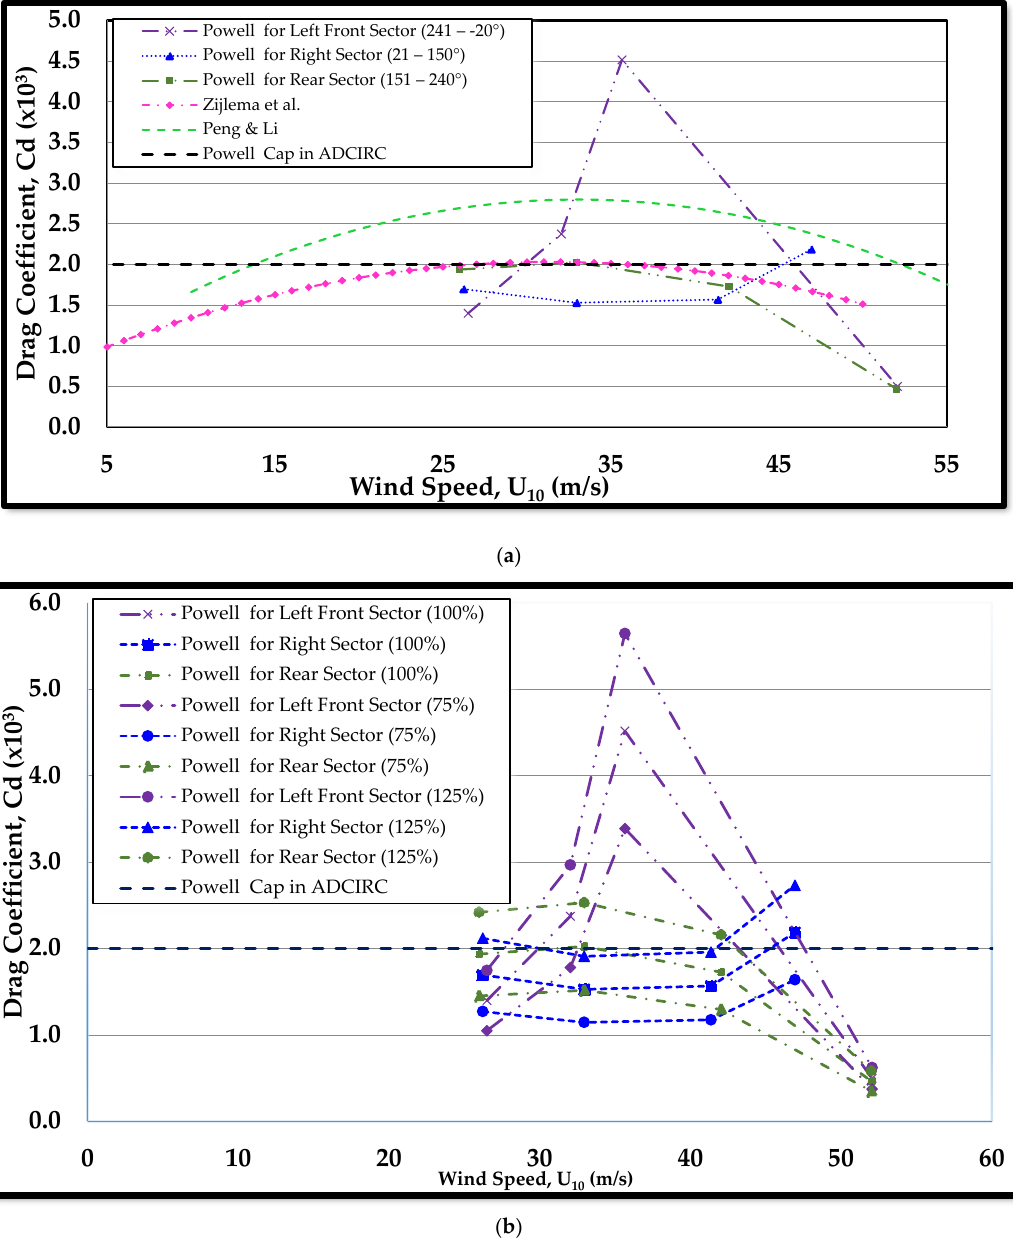
Figure 2. Drag coefficient profiles as functions of wind speed, ( a ) popular drag formulations used in the present study; ( b ) 75% and 125% bounds of Powell’s [44] sector based drag coefficients. The OceanWeather Inc. (OWI) structured and data-assimilated wind and pressure fields are used as the default wind model, similar to Kerr et al. [1]. To study the effect of other meteorological forcing options, the following meteorological setups are used in instead of the OWI model: (1) NOAA National Hurricane Research Division (NHRD) HWIND Model; (2) Planetary Boundary Layer (PBL) Model; (3) Dynamic Holland Model (HM); and (4) Asymmetric Holland Model (AHM). Some technical details of these models are presented below. The OWI wind field for Rita was generated by blending of TC96 (short for Thompson and Cardone, 1996) mesoscale model [30], an inner core wind field transformed to 30 min averaged sustained winds with gulf scale winds using the Interactive Objective Kinematic Analysis (IOKA) system [11,38]. The hindcast winds use measurements from anemometers, airborne and land-based Doppler radar, microwave radiometers, buoys, ships, aircrafts, coastal stations, and satellite measurements. HWIND wind field “snapshots” are generated at 6-h intervals after aircraft reconnaissance missions in a given system is done [49]. HWIND incorporates a comprehensive set of observational data sources spanning more than thirty land, air, and sea-based platforms, such as aircraft reconnaissance, dropsondes, airborne Doppler radar wind measurements, buoys, satellites, and coastal observation networks. HWIND datasets include integrated kinetic energy, which is considered to be the index for measuring tropical cyclone size and intensity, and an alternative to the Saffir-Simpson Scale. One drawback of HWIND is the lack of wind field “snapshot” data soon after the hurricane makes landfall, which is needed for storm surge hindcasting. For the present study, the latest available HWIND snapshot is extrapolated in time with adjustments in storm position and a gradual reduction factor of the hurricane intensity. For Hurricane Rita, the last snapshot available is at 24 September, 10:30 AM. For the next 24 h, this snapshot is used by replacing its eye location with the current eye location and assigning an intensity reduction factor less than 1 (e.g., 0.9, 0.6, 0.5, and 0.4 for 24 September noon, 6 PM, 25 September midnight, and 6 AM, respectively, are used in the present study). These reduction factors are approximated from the ratios of maximum wind speeds